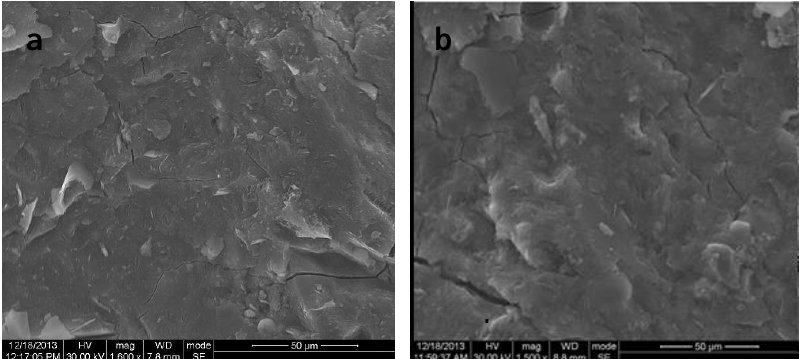
Figure 11. SEM micrographs of geopolymer mortars after thermal treatments up to 700 °C ( a ) 0% wt, ( b ) 30% wt of FBA.